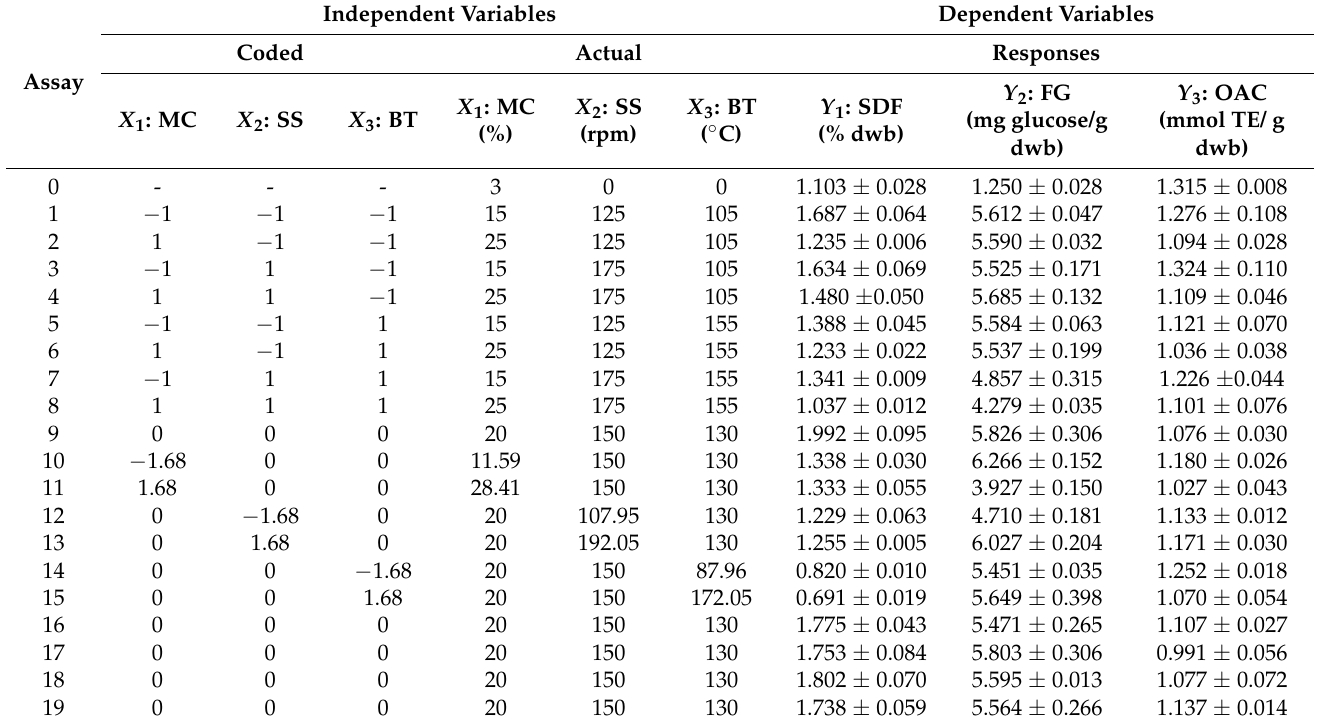
Table 1. CCRD and response